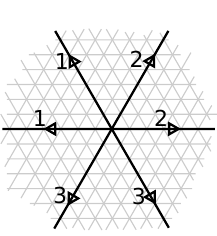
Figure 35 . Four lifts of a link segment crossing a critical leaf of F approx , using the detours shown in figure 34.